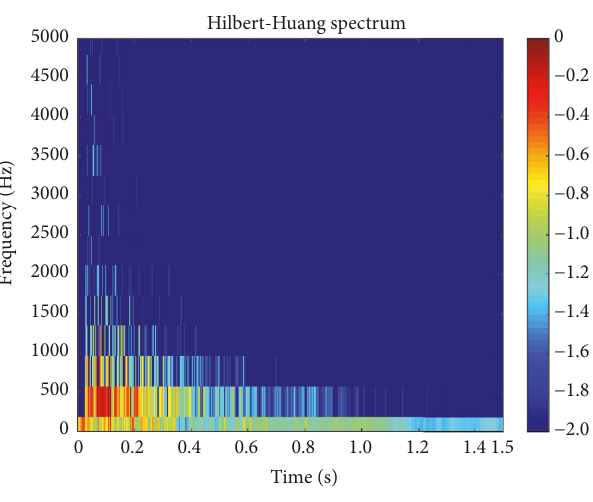
Figure 10: Frequency spectrum of vibration velocity signal at inner surface. Note . The color bar on the right represents the magnitude of vibration amplitude; the deeper the color, the greater the